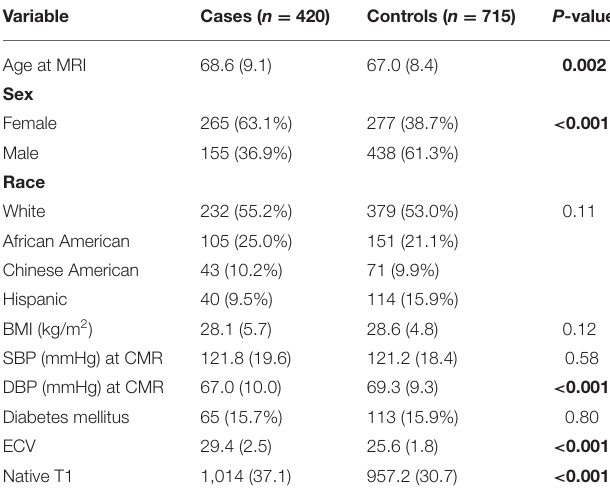
TABLE 1 | Variable distribution among cases vs.